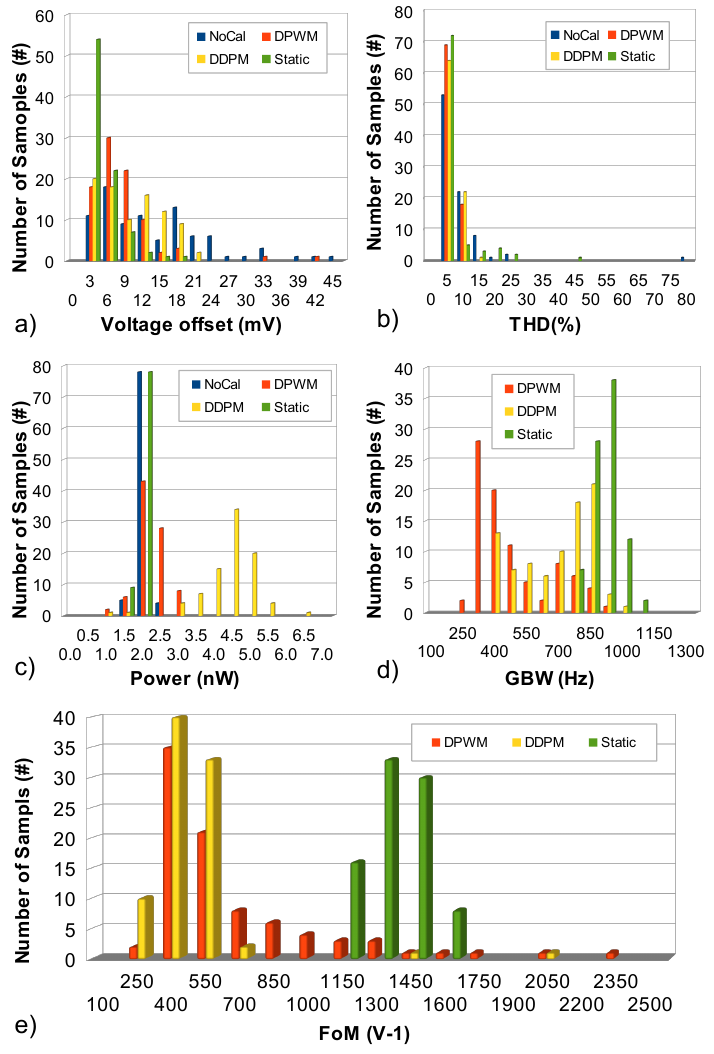
histograms. I DD